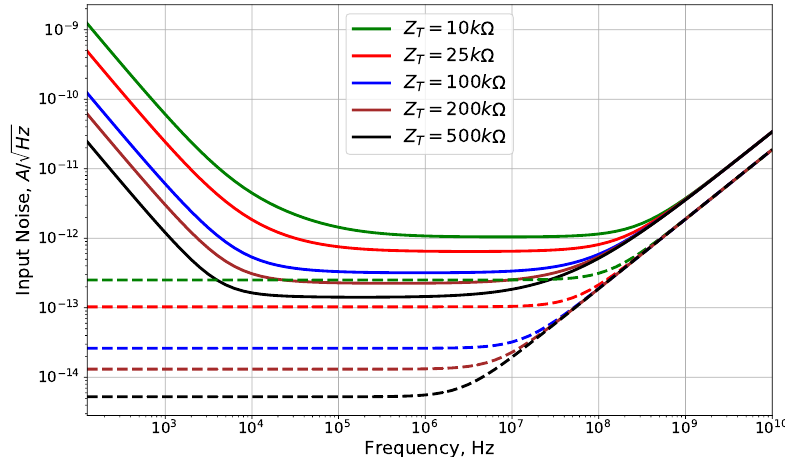
Figure 11. The noise model from Keshri applied for our set of circuit parameters (dashed lines) and our developed complete analytical noise model for the same set of parameters (solid